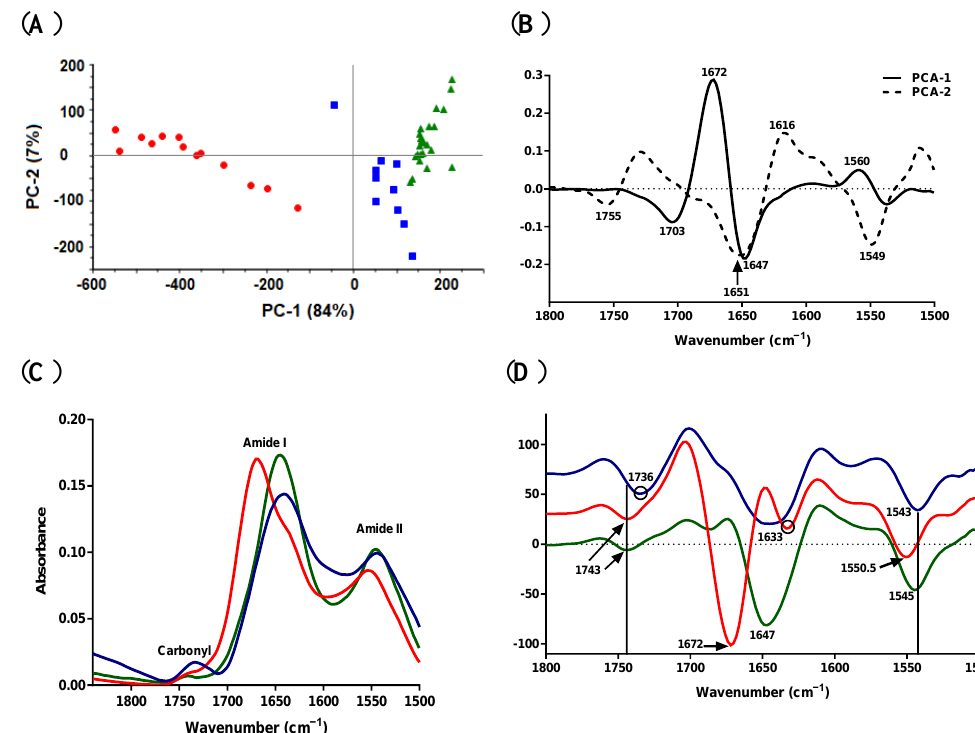
Figure 4. SR-FTIR spectra of protein-carbonyl region from S. aureus wild type (SaW; red), combined natural SCV and hemB mutant (SCVhMu, green) and complemented mutant (SaCMu, blue). ( A ) PCA score plot. ( B ) Loading plot of PC-1 and PC-2 of PCA model. ( C ) Unit-vector-normalized average raw spectra. ( D ) Normalized reduced Savitzky–Golay second-derivative average spectra.